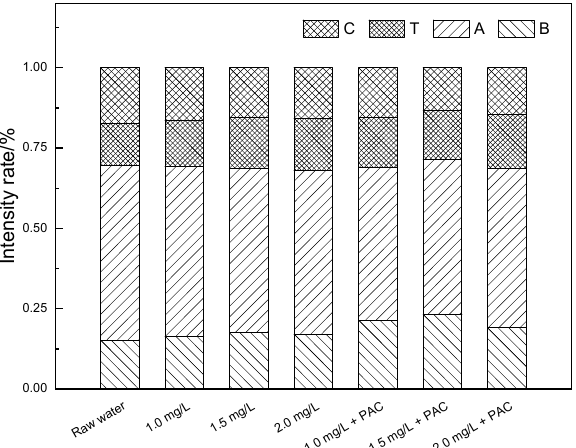
Figure 6. Proportion of the standard volume integral intensity of a NaClO pre-oxidation hydro fluorescent spectra. Membranes 2021 , 11 , x FOR PEER REVIEW In the O 3 added ceramic membrane filtration system (Figures 7 and 8), when the O 3 concentration was 0.5 mg/L, the response peaks in the A and C regions of the effluent samples were obviously weakened and the protein peak in region B showed no significant change. When the concentration increased to 1.0 mg/L, the protein substance decreased significantly, but the peak response in the C region increased a little. With the further increase in the O 3 concentration, the response in each part of the fluorescence region was reduced. After coagulation treatment, the effluent quality of the system increased greatly, and the treatment’s effect was better than that of the NaClO. When the O 3 concentration was low, the oxidation ability was weak, and the effect of oxidizing macromolecules was poor. Increasing the concentration made the O 3 react incompletely with protein macro- molecules and produce hydrophilic small molecular substances, increasing the response peak intensity in the A and C regions. When the O 3 dosage was further increased, most of the organic matter was removed. In the O 3 pre-oxidation combined with the coagula- tion/ceramic membrane system, the O 3 and coagulation had a synergistic effect and thus the effluent quality was better than that of a non-coagulant system. The difference in the three-dimensional fluorescence spectrum of the effluent with different O 3 concentrations was not significant, indicating that the combined process could be optimized just using O 3 of a low concentration.